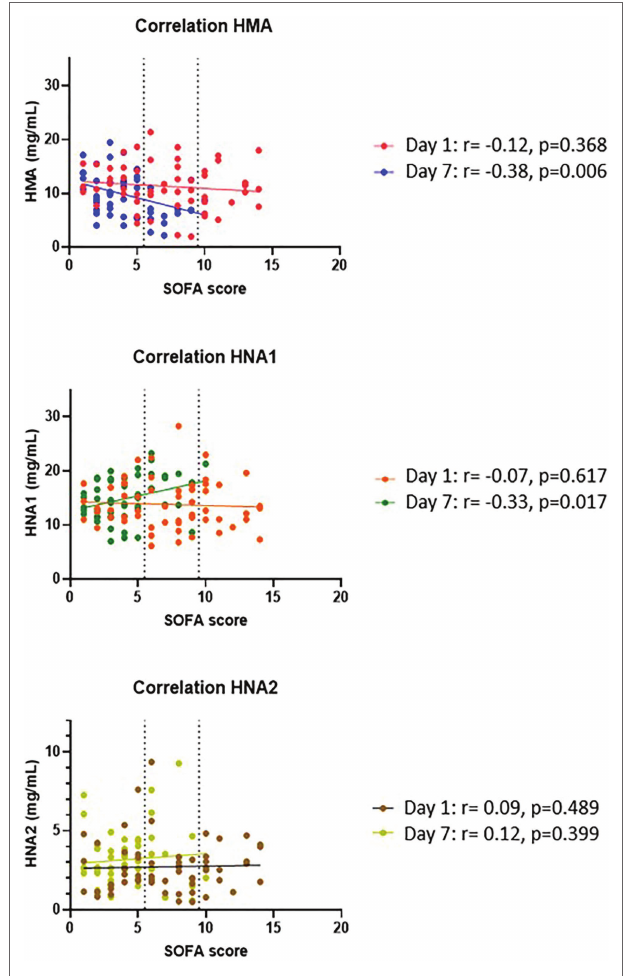
FIGURE 3 | Correlation of albumin oxidation forms and SOFA score. Albumin forms at day 1 and day 7were correlated with the corresponding SOFA scores by means of Pearson or Spearmen rank, depending on the distribution of the data.